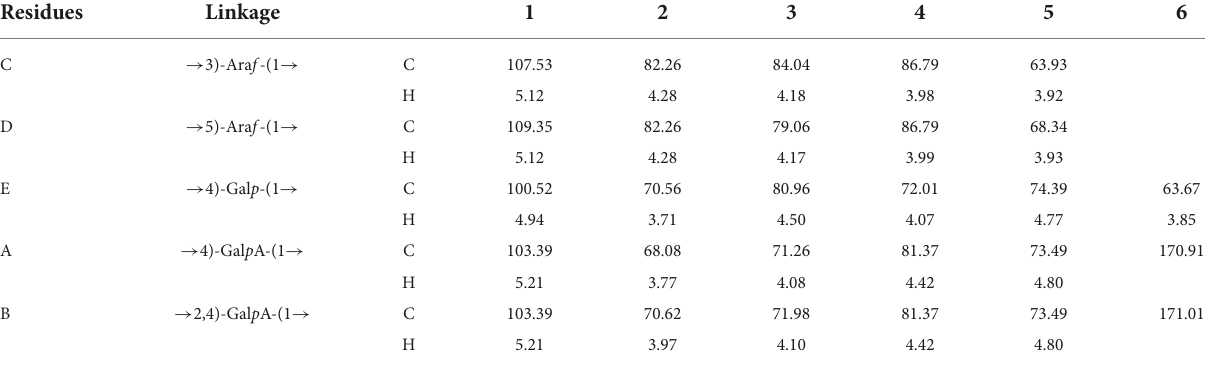
TABLE 2 PZMP3-1’s 1 H and 13 C nuclear magnetic resonance spectroscopy (NMR) data.